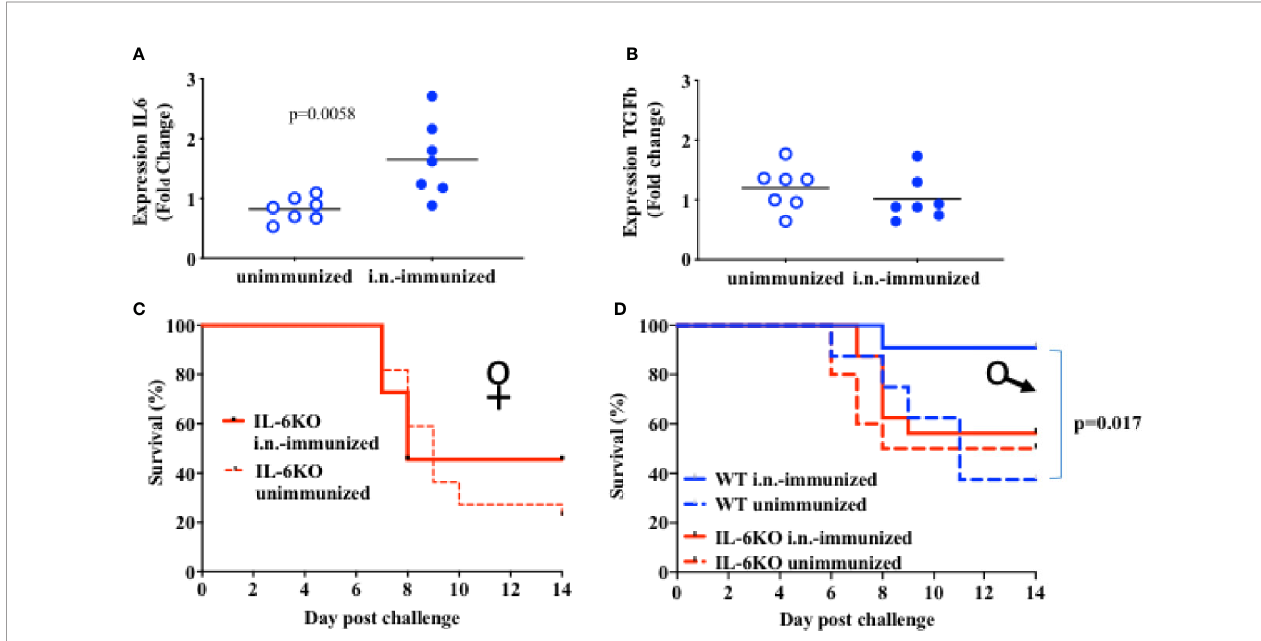
FIGURE 4 | IL-6 is necessary for protective response to an i.n. administration of heat inactivated in fl uenza virus. (A, B) : On day 16 of life mice received 5 × 10 5 EIU of heat-inactivated virus intranasally (Dk blue) or not (Lt blue). At 2 days after immunization, lungs were harvested and whole lung was used to extract RNA that was later assayed for RNA expression of IL-6 (A) and for TGFb (B) by QPCR. Each symbol represents one mouse. Shown is fold-change relative to unimmunized mice in a single experiment. The t-test was used to test for signi fi cant differences between groups. (C, D) : Mice aged 14 – 17 days of life were i.n.-immunized (bold) with 5 × 10 5 EIU heat inactivated virus or left unimmunized (dashed). Three weeks later, all mice received a lethal dose of live virus. Y Axis, survival. X axis, day post challenge. (C) IL-6KO Female mice; i.n.-immunized, n = 11; unimmunized, n = 22. (D) Male mice; IL-6KO (red) i.n.-immunized, n = 16; unimmunized, n = 10. WT males (blue) i.n. immunized n = 11, unimmunized, n = 8). Shown is Mantel-Cox (log-rank) analysis of total data using % initial weight as noted in methods from 5 independent cohorts of mice receiving immunization and or challenge. Signi fi cance was set at p <